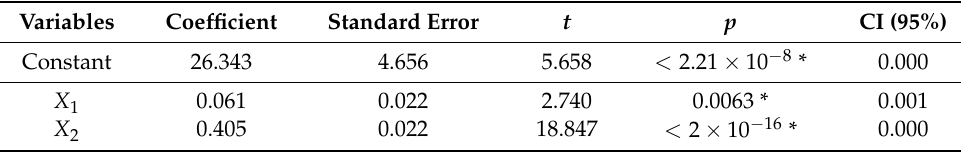
Table 6. Association between performance and digital deliberate